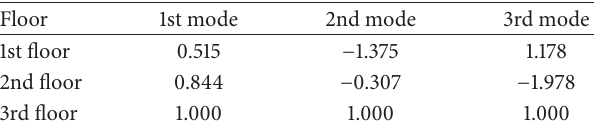
Table 15: Results of mode shape